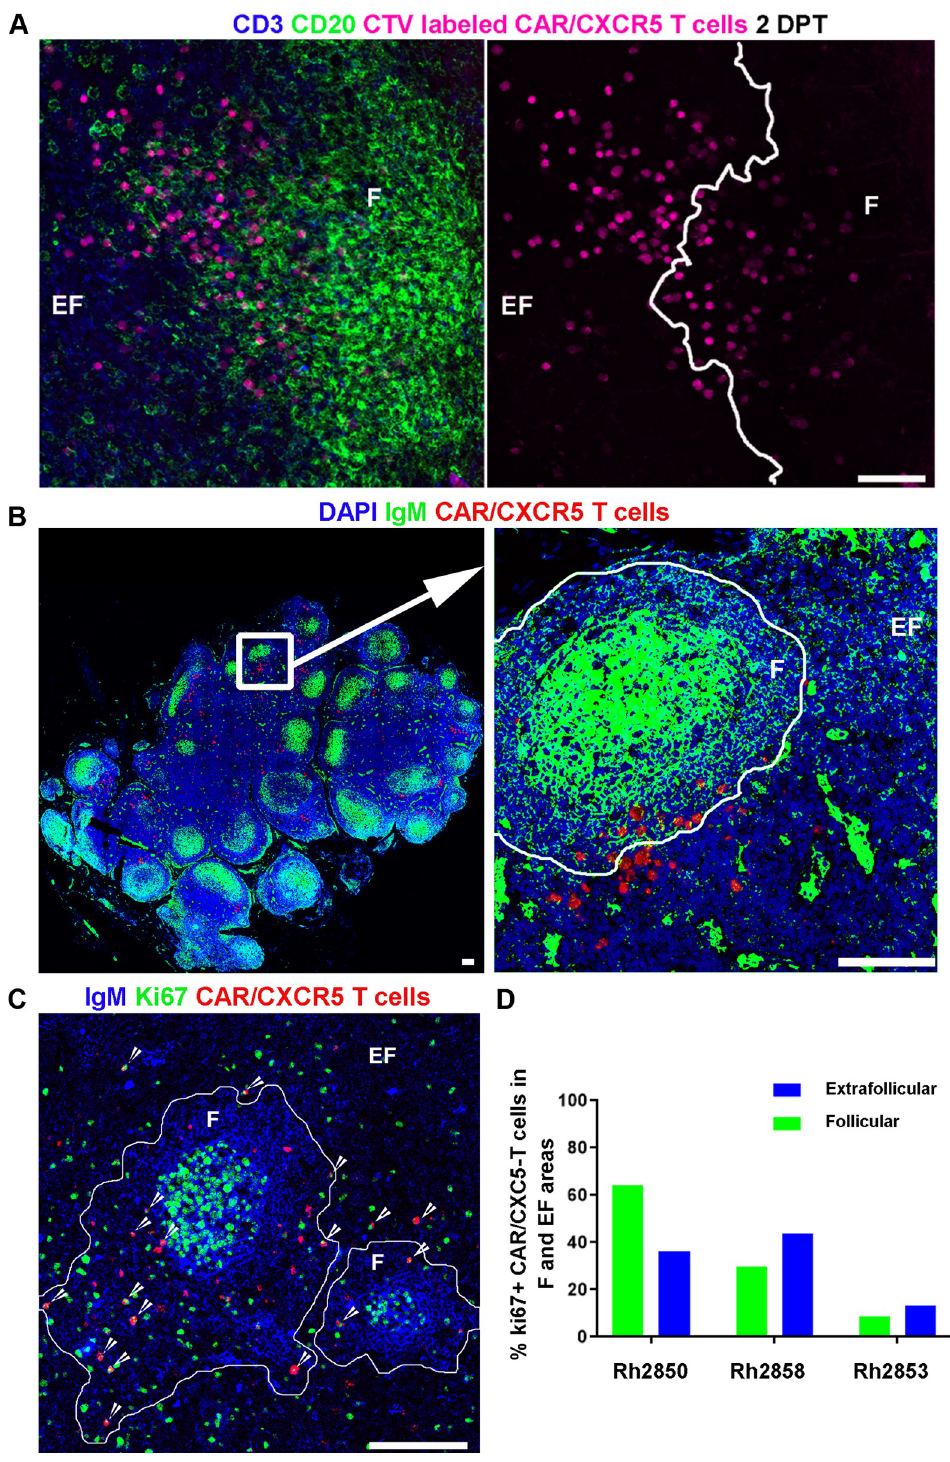
Fig 5. CAR/CXCR5-T cells continue to expand in vivo. CAR/CXCR5-T cells expanded at the edges of B cell follicles in vivo at 2 DPT and accumulated within B cell follicles at 6 DPT. (A) Representative image from LN tissue from Rh2850 stained 2 DPT showing CTV-labeled cell proliferation in the extrafollicular (EF) area near the follicular (F) zone. Tissues were stained with anti-CD3 (blue) to label T cells and anti-CD20 (green) to label B cells and delineate B cell follicles (F). The infused T cell product labeled with CTV is pseudo-colored magenta. Cells within F showed lower